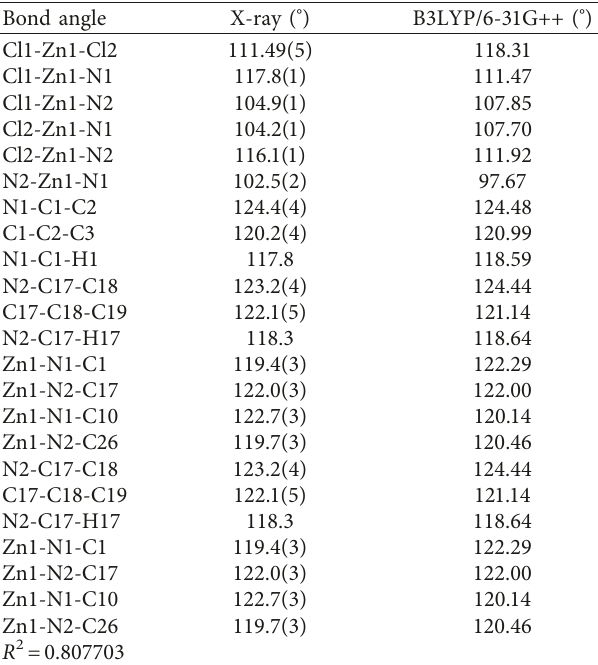
Table 3: Selected bond angles (experimental and calculated) for the [ZnCl 2 (BS-4-OCH 3 ) 2 ]